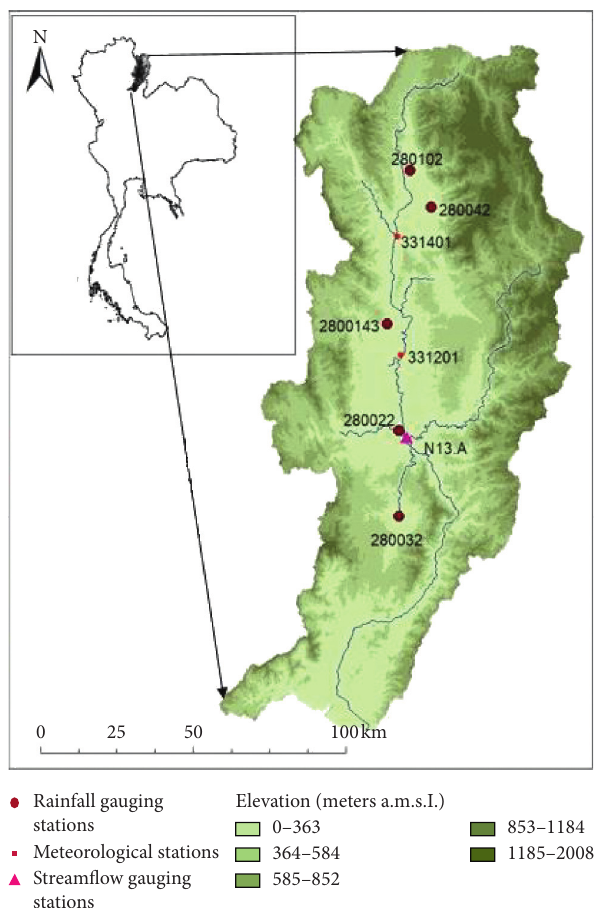
Figure 1: Rainfall stations, meteorological stations, and streamflow stations in the upper Nan River basin of Northern